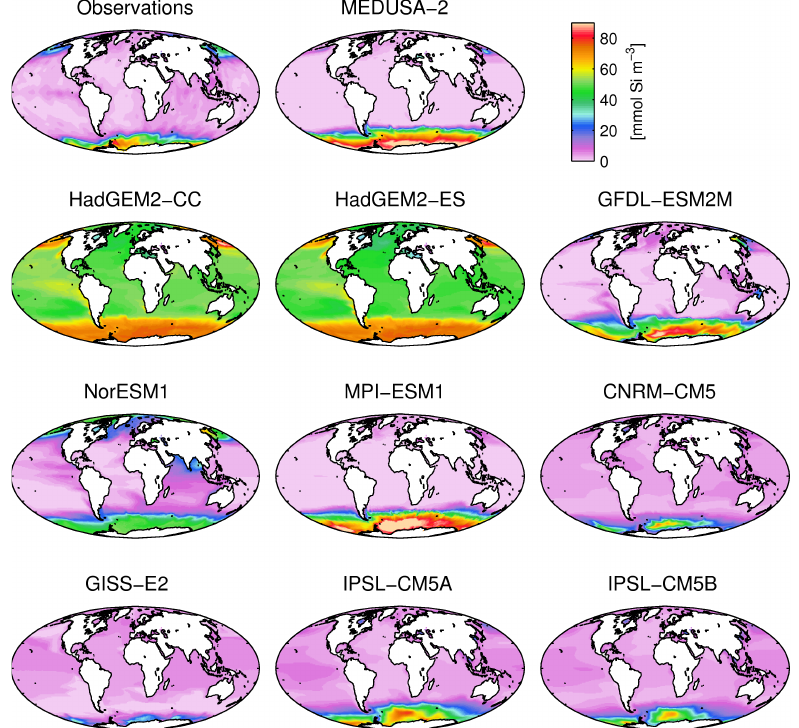
Fig. 43. Intercomparison of annual mean surface silicic acid for M EDUSA -2.0 and a range of comparable CMIP5 models. Silicic acid concentration in mmolSim − 3